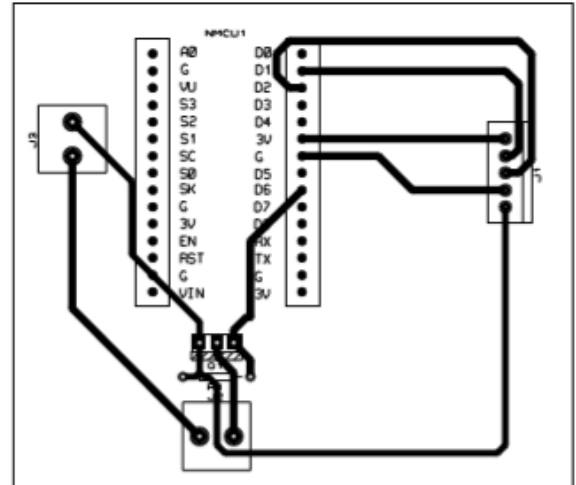
Figure 3.2. Test Faces